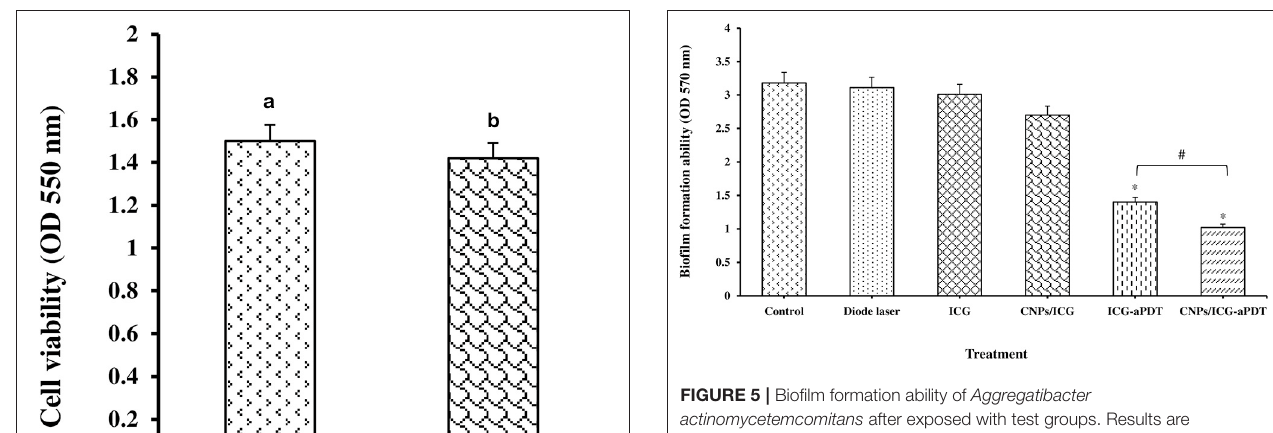
to Figure 4 , the reduction in the planktonic growth of A.